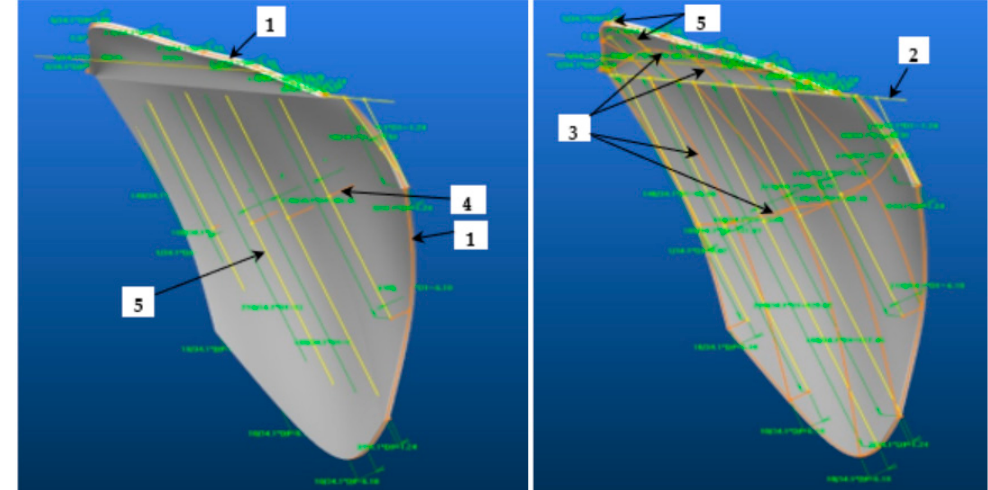
Figure 11. The two views of the scapula with the supraspinous (1) and infraspinous fossa (2).